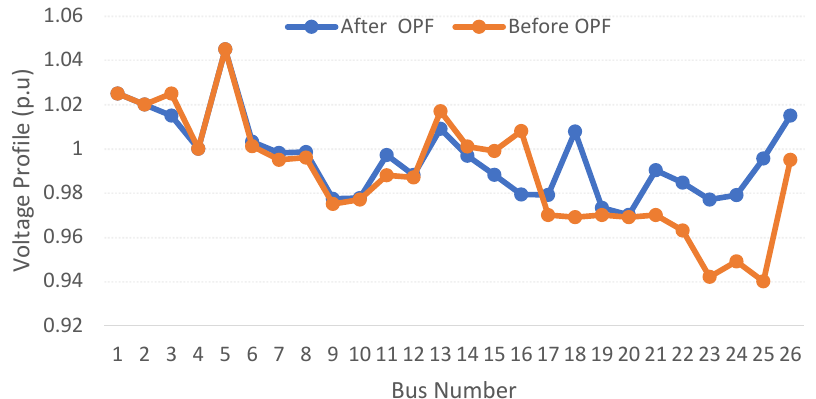
Figure 2. Voltage profile before and after NSGA-OPF.